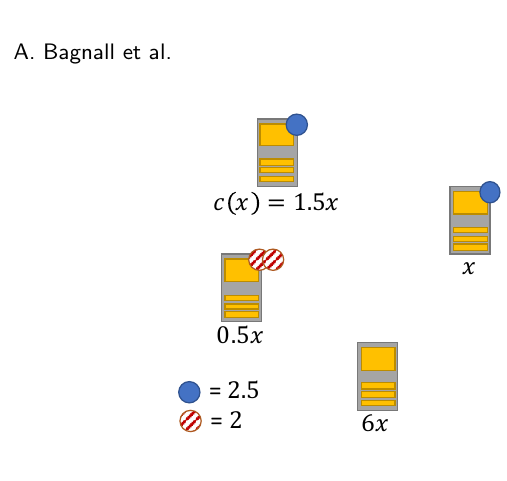
Fig. 3. An Affine Congestion Game Mapping Two Players (Blue–Solid, Red–Hatched) to 4 Servers. Costs incurred by each player are listed in the lower left. (cid:80) (1 ≤ z < (traffic edge s (cid:48) x y ).+1) ecosts x y z − (cid:80) (1 ≤ z < (traffic edge s x y ).+1) ecosts x y z = ecosts x y (traffic edge s (cid:48) x y ) − 0 which by traffic10 can be rewritten in terms of s as: (cid:80) (1 ≤ z < (traffic edge s x y ).+2) ecosts x y z − (cid:80) (1 ≤ z < (traffic edge s x y ).+1) ecosts x y z = ecosts x y (traffic edge s x y ).+1 − 0 The left-hand side equals: ecosts x y (traffic edge s x y